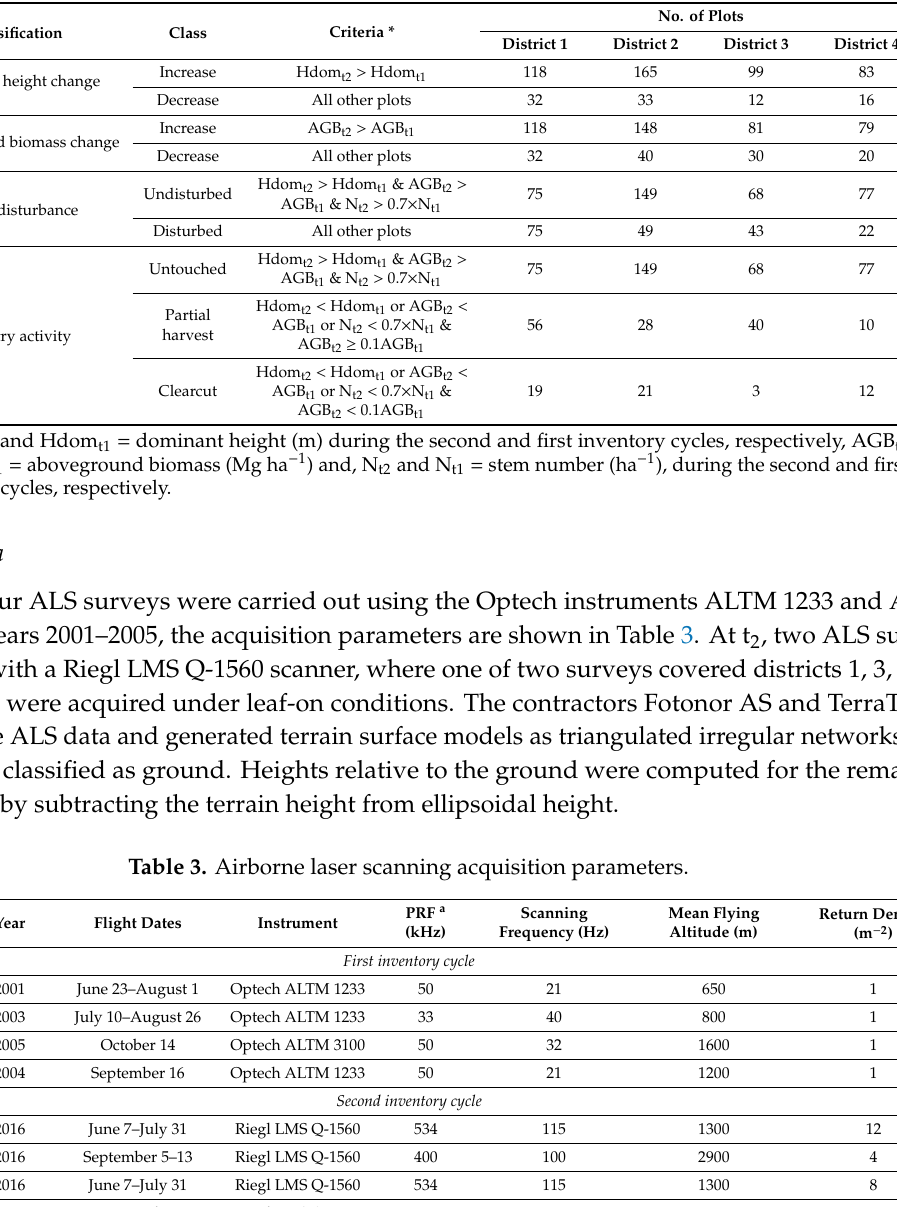
Table 2. Criteria for the classification schemes and numbers of plots within classes.